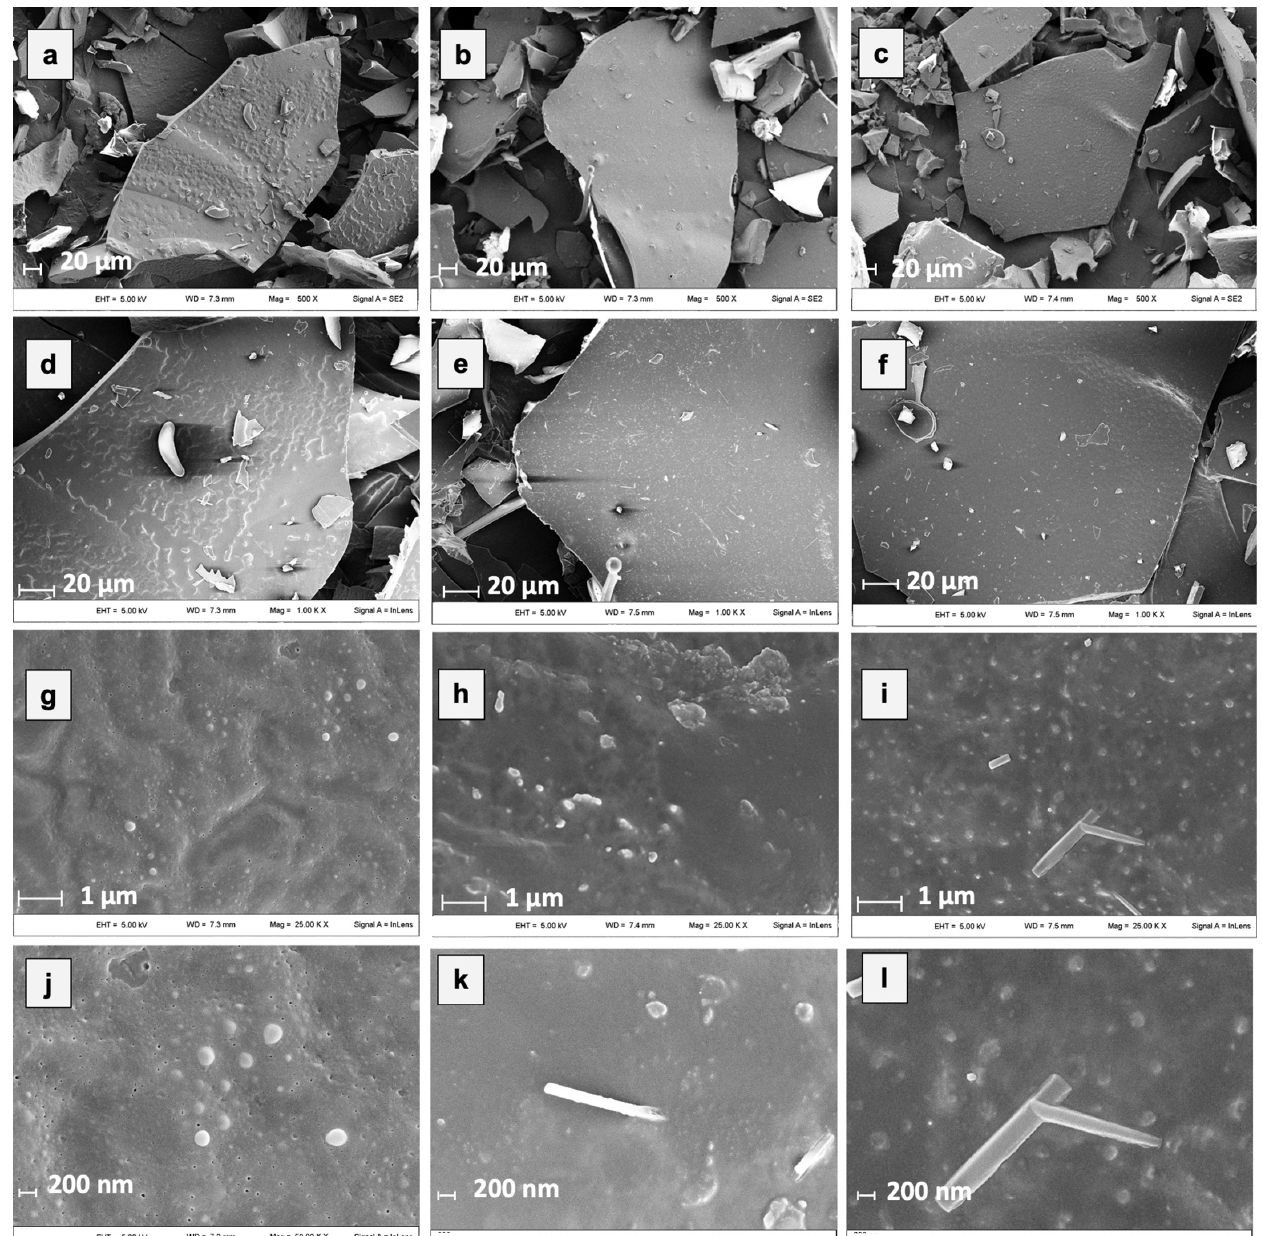
Figure 3. Micrographs of different microencapsulated hop extracts at different magnifications. In detail: ExMD ( a , d , g , j ); ExGA ( b , e , h , k ), and ExMD-GA ( c , f , i , l ).